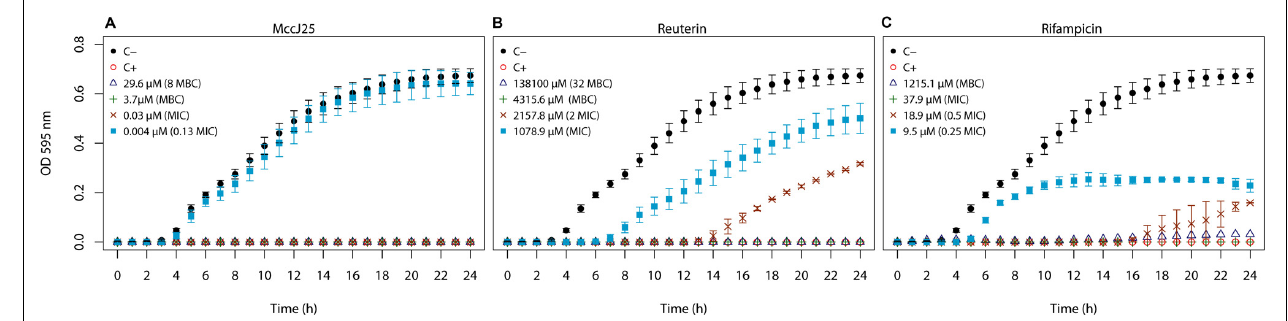
FIGURE 1 | Growth of Salmonella enterica subsp. enterica serovar Newport ATCC 6962 in 96 well micro-plates in LB broth supplemented with (A) MccJ25 at 29.6 µ M (8 × MBC) (cid:52) , 3.7 µ M (MBC) + , 0.03 µ M (MIC) × and 0.004 µ M (0. 13 MIC) (cid:4) , (B) reuterin at 138100 µ M (32 MBC) (cid:52) , 4315.6 µ M (MBC) + , 2157.8 µ M (2 MIC) × and 1078.9 µ M (MIC) (cid:4) , or (C) rifampicin at 1215.1 µ M (MBC) (cid:52) , 37.9 µ M (MIC) + , 18.9 µ M (0.5 MIC) × and 9.5 µ M (0.25 MIC) (cid:4) . Optical density was measured at 595 nm. C- is the negative control (LB broth only) and C+ ◦ the positive control (LB broth + MccJ25 at 474.6 µ M). Data are means of two (cid:32) independent experimental repetitions. TABLE 1 | Minimal inhibitory concentrations (MIC) and minimal bactericidal concentrations (MBC) of MccJ25, reuterin and rifampicin in LB broth using Salmonella enterica subsp. enterica serovar Newport (ATCC 6962) in 96-well micro-assay plates. MccJ25 Reuterin